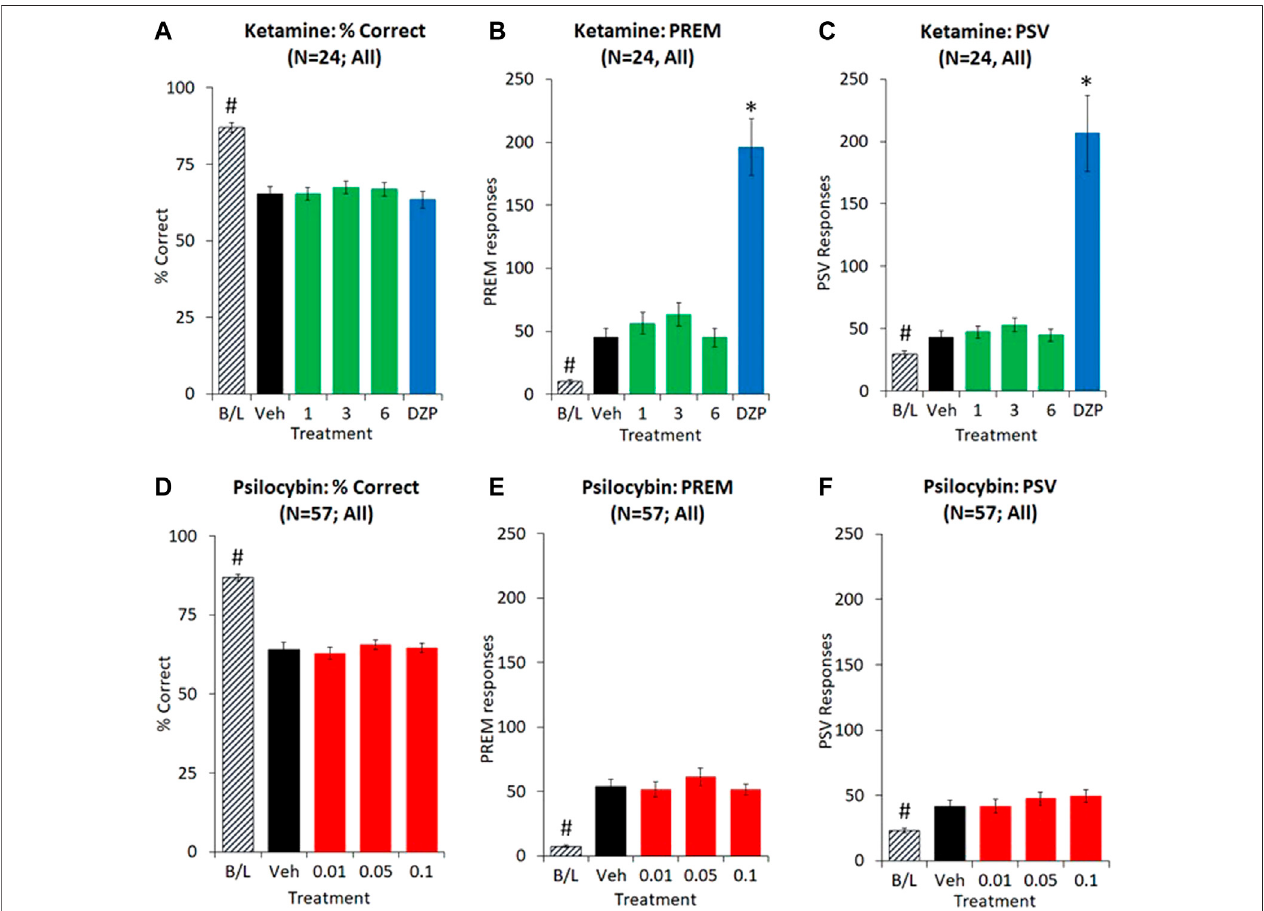
FIGURE 4 | Characterisation of ketamine (1 – 6 mg/kg IP) and psilocybin (0.01 – 0.1 mg/kg SC) on performance of rats in the 5-choice serial reaction timetask. Test conditions of 0.3 s SD, 10 s ITI, 100 trials; i.e. extended ITI. Data is presented for both drugs as % correct, (A and D) , total number of premature (PREM) responses (B and E) , and total number of perseverative (PSV) responses (C and F) . Dizocilpine (DZP, 0.02 mg/kg SC) was included as a reference comparator in the ketamine experiment. Ketamine experiment: N (cid:1) 24; Psilocybin experiment: N (cid:1) 57. * p < 0.05 vs. vehicle control, # p < 0.05 vs. all treatment groups (Dunnetts test following signi fi cant